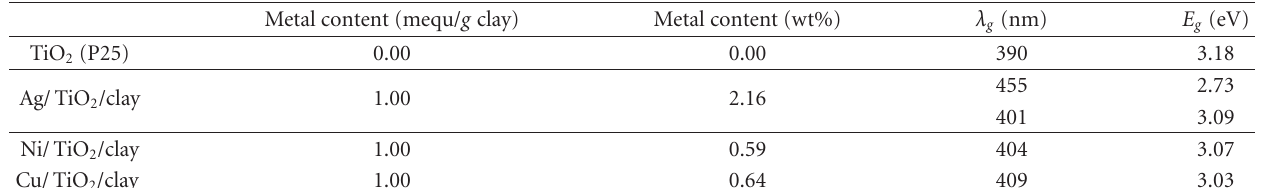
Table 1: The composition and optical properties of the catalysts.